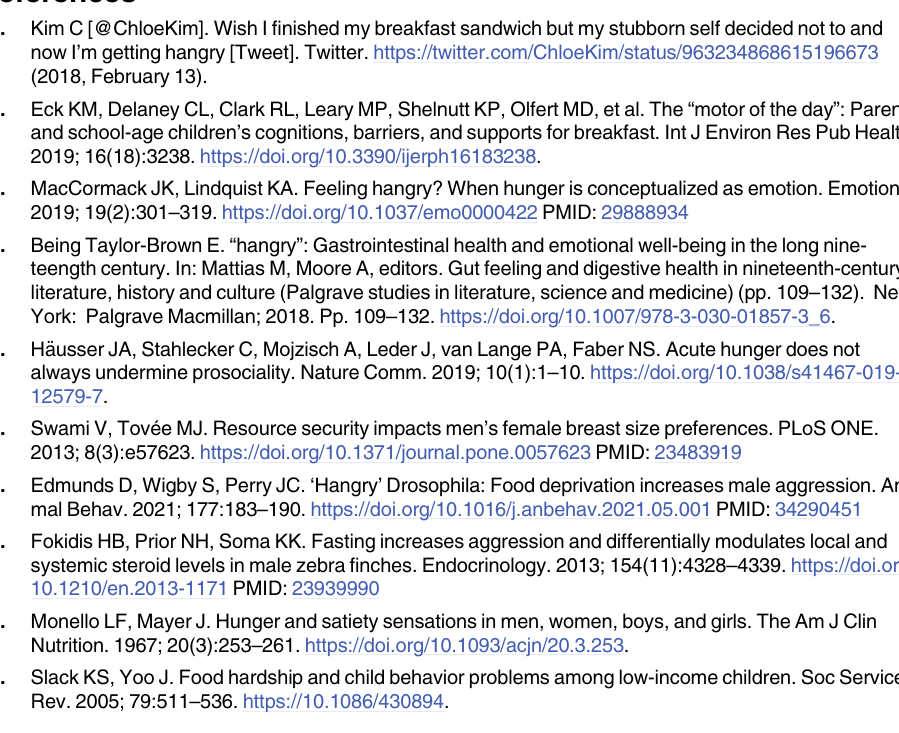
S1 Table. Reliabilities of level 2 measures. S2 Table. Results of the multi-level analyses assuming a negative binomial distribution for the criterion. S3 Table. Results of the multi-level analyses using a compound measure of irritability, anger, and pleasure for the